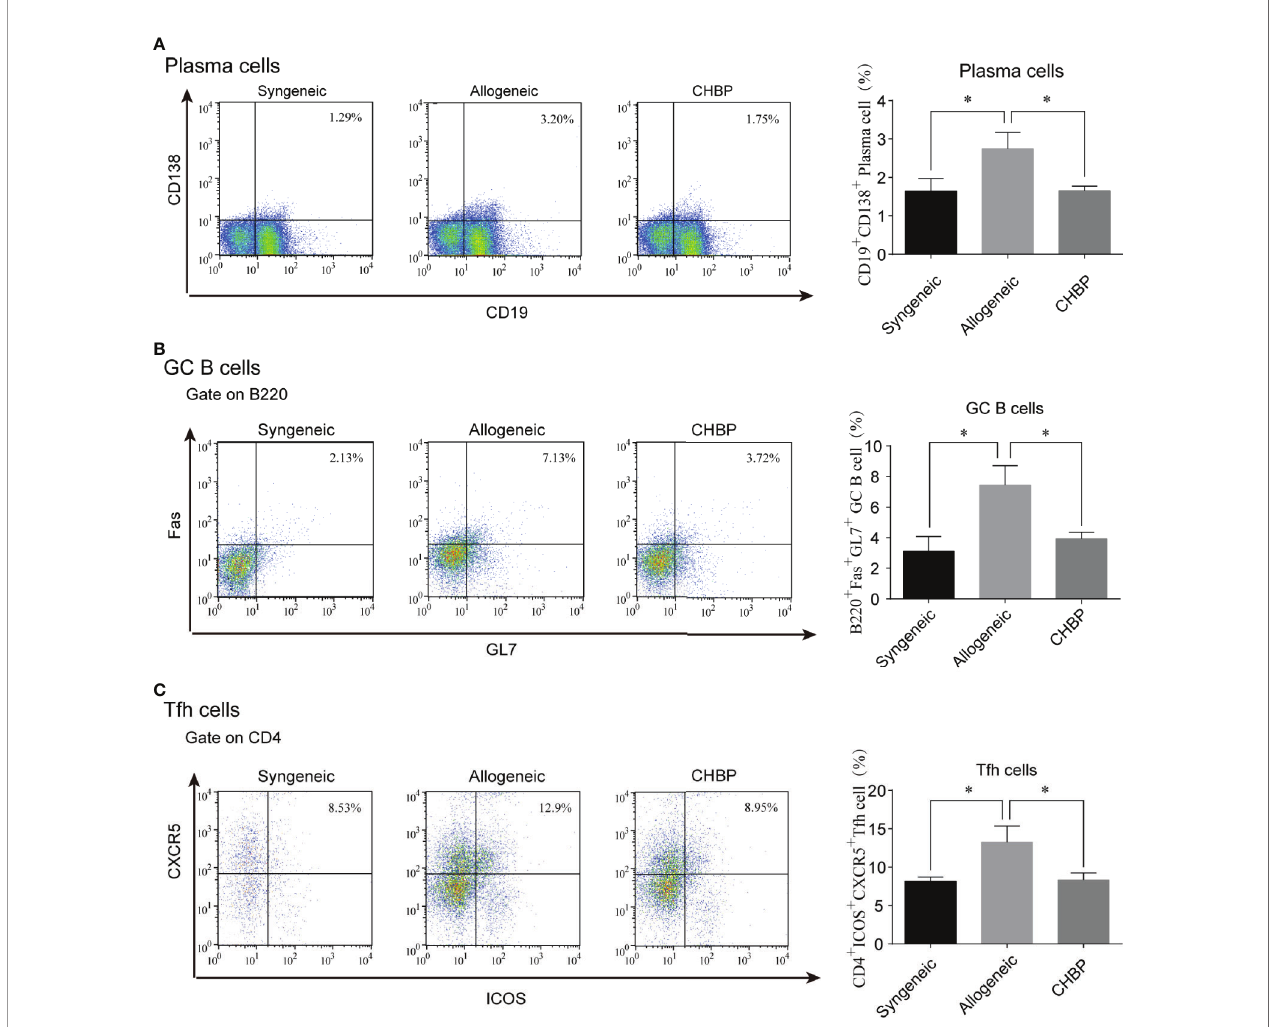
FIGURE 3 | CHBP decreased the percentages of plasma cells, GC B cells, and Tfh cells in the spleen. Percentages of (A) CD19 + CD138 + plasma cells, (B) GL7 + B220 + Fas + GC B cells, and (C) CD4 + CXCR5 + ICOS + Tfh cells in the spleen in each group. *P <